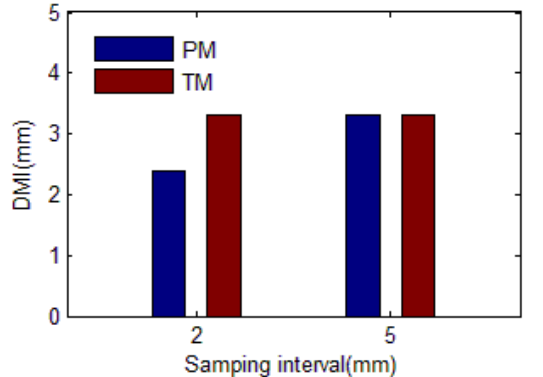
Figure 6. The DMI calculated using the PM and TM method respectively for each sampling interval.